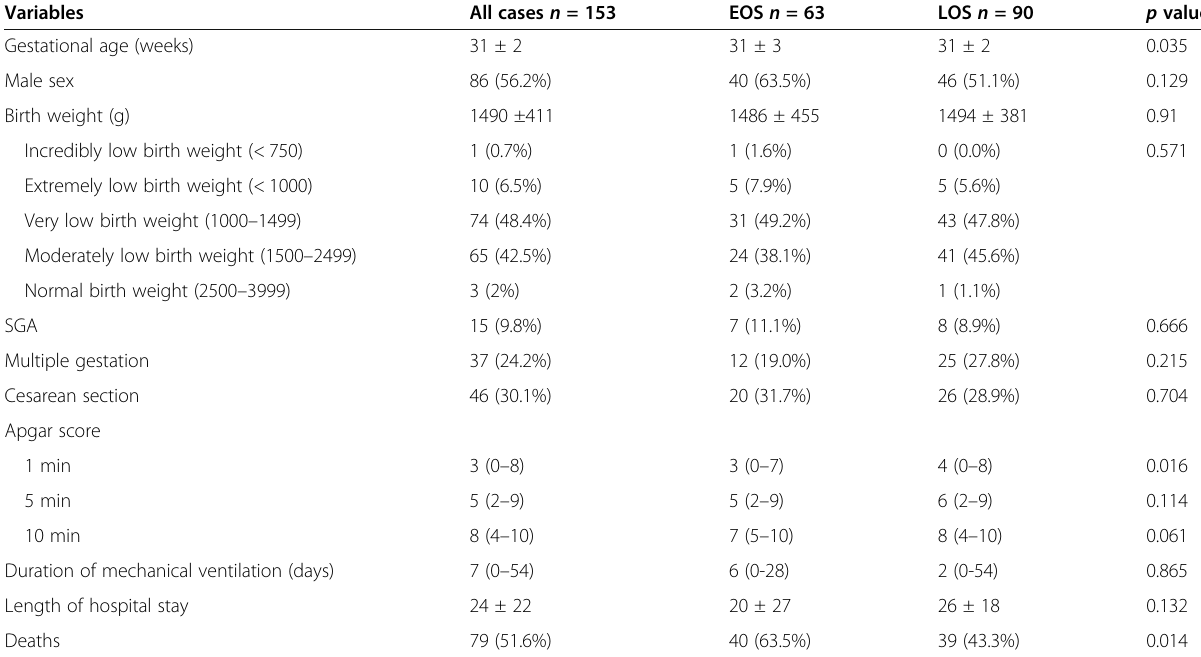
Table 1 Baseline characteristics of the studied